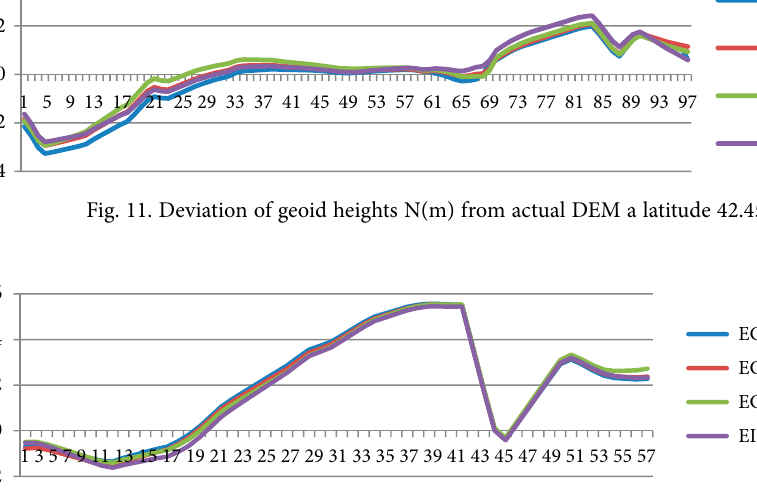
Fig. 12. Deviation of geoid heights N(m) from actual DEM a latitude 42.30